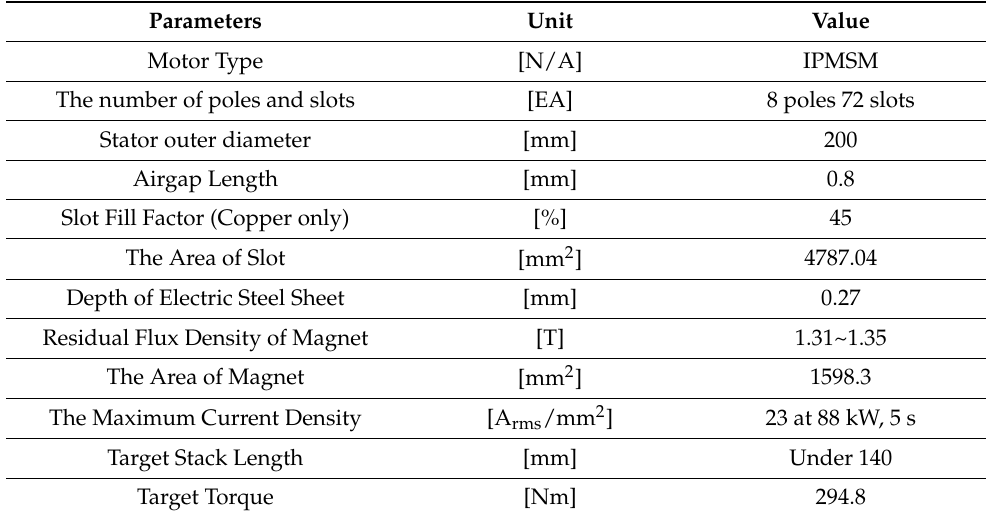
Table 5. Specifications of the designed motor.